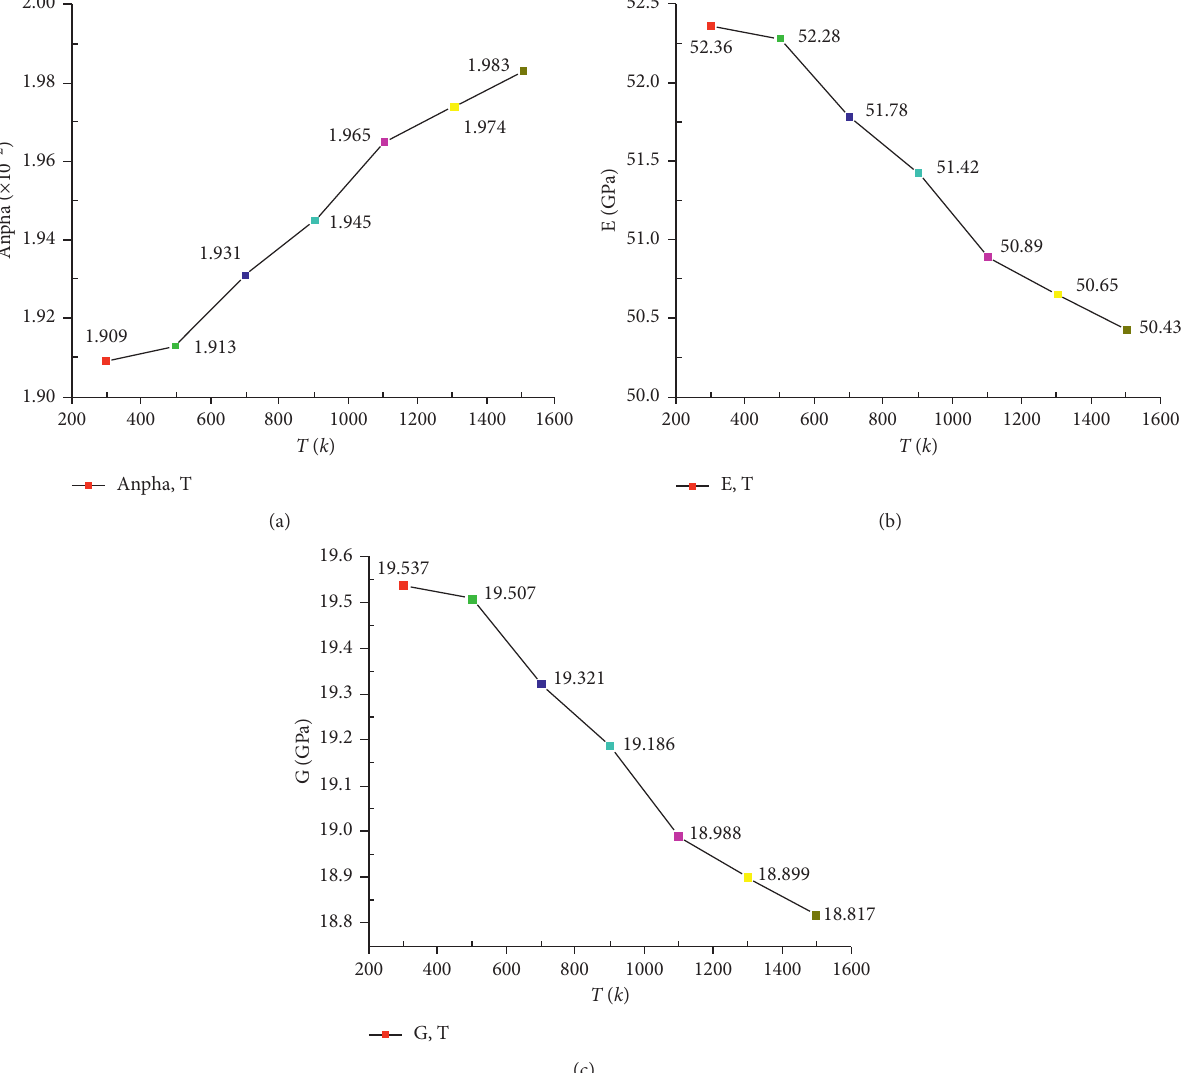
Figure 8: The mechanical properties as anpha (a), E (b), and G (c) of amorphous aluminum at different